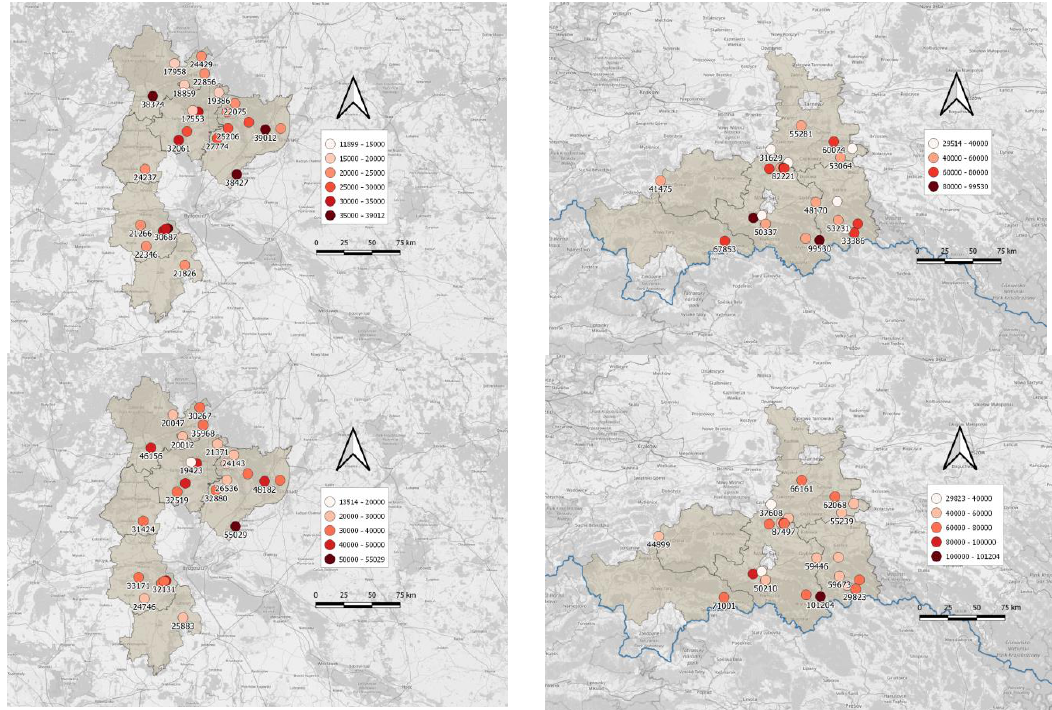
Figure 5. Spatial distribution of forest property assessed values within the study areas. Note: upper panel is based on valuation tables from 1985 and lower panel is based on valuation tables from 2013. Source: own elaboration. ( left ) North (Swiecie, Tuchola, Naklo, Sepolin, Znin, and Chojnice). ( right ) South (Gorlice, Nowy Sacz, Limanowa, and Tarnow).